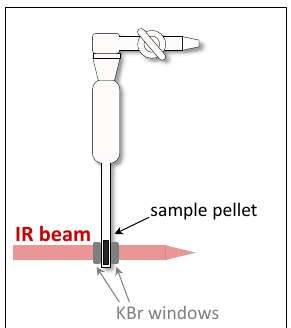
Figure 5. Transmission (TIR) mode, where the IR beam is directed through a self-sustained sample placed inside the catalytic reactor and collected after exiting for analysis.